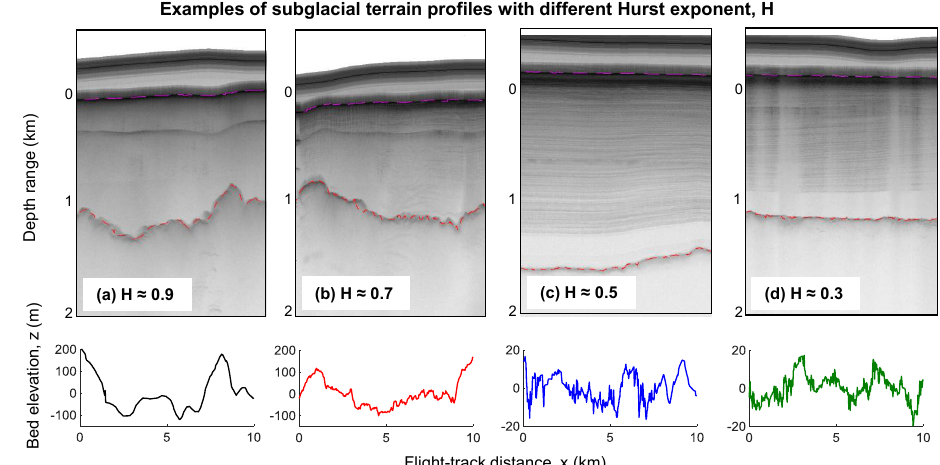
Figure 1. Example radargrams (top panel) and 10km bed elevation profiles (bottom panel) for subglacial terrain with different Hurst ex- ponent, H : (a) H ≈ 0 . 9 (near self-similar), (b) H ≈ 0 . 7 (between Brownian and self-similar), (c) H ≈ 0 . 5 (Brownian), and (d) H ≈ 0 . 3 (sub-Brownian). The location of the profiles are shown in Fig. 3. Evident in the radargrams are the surface reflection (pink line), the bed reflection (red line), and reflections from internal layers in ice. The bed elevation profiles are linearly detrended about zero with horizontal resolution ∼ 30m. The horizontal–vertical aspect ratio of the bottom panels differs between (a) , (b) and (c) , (d) by a factor of ∼ 10.